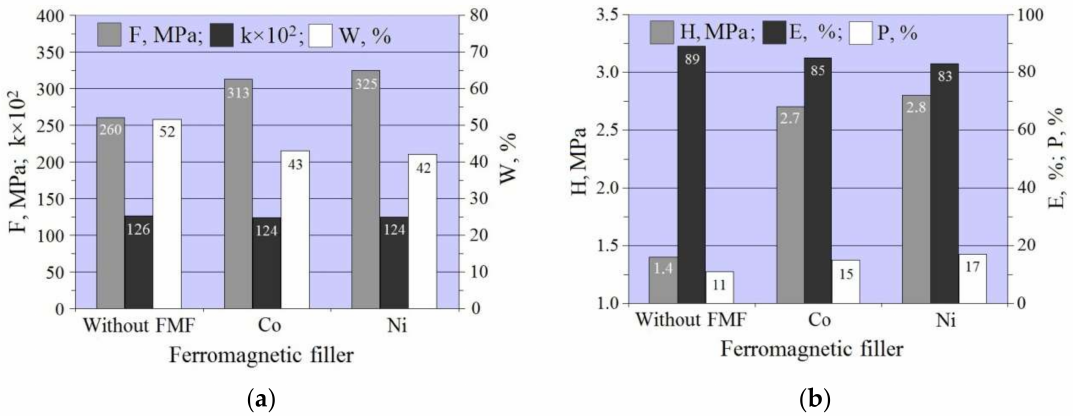
Figure 16. The effect of FMF presence on the physico-mechanical properties of pHEMA-gr-PVP copolymers in dry ( a ) and swollen ( b ) states (HEMA:PVP = 80:20 mass parts; [FMF] = 10 wt.%).